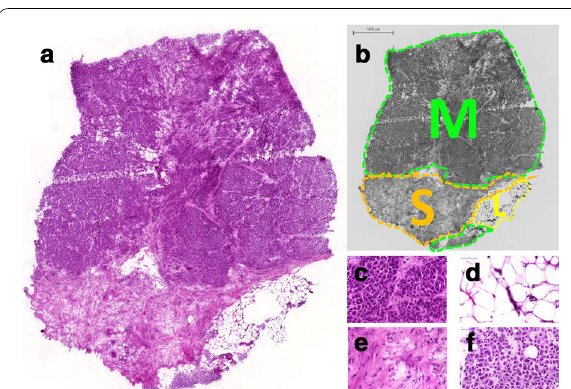
Fig. 7 Histological images of a tissue sample displaying: a overview with low magnification (1 , HE stain), b an annotated area (M: × tumour, S: connective tissue, L: fat tissue), c – f high magnification images of the resultant regions representing ( c ) melanoma from upper region, d fat tissue, e connective tissue, f melanocytes from lower region (53 , HE ×